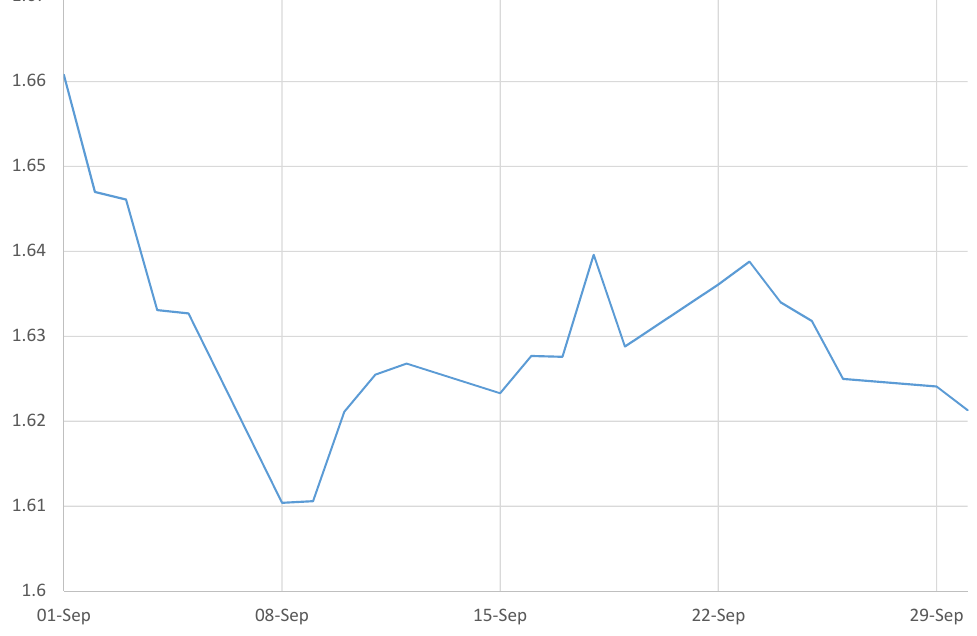
Figure 9. Historical FX spot rates for GBPUSD (1 to 30 September